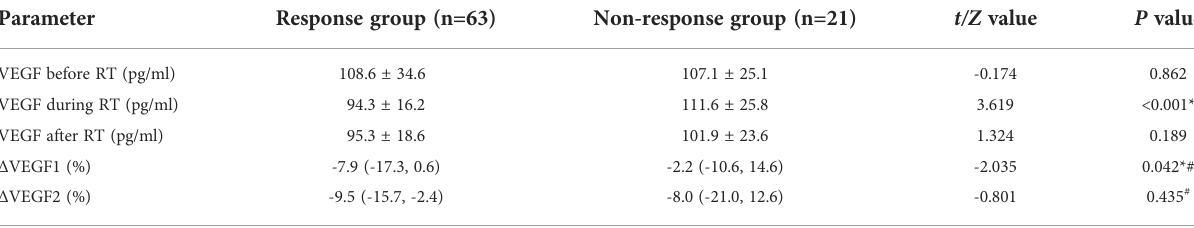
TABLE 2 Changes of blood VEGF before and after radiotherapy in response group and non-response group.